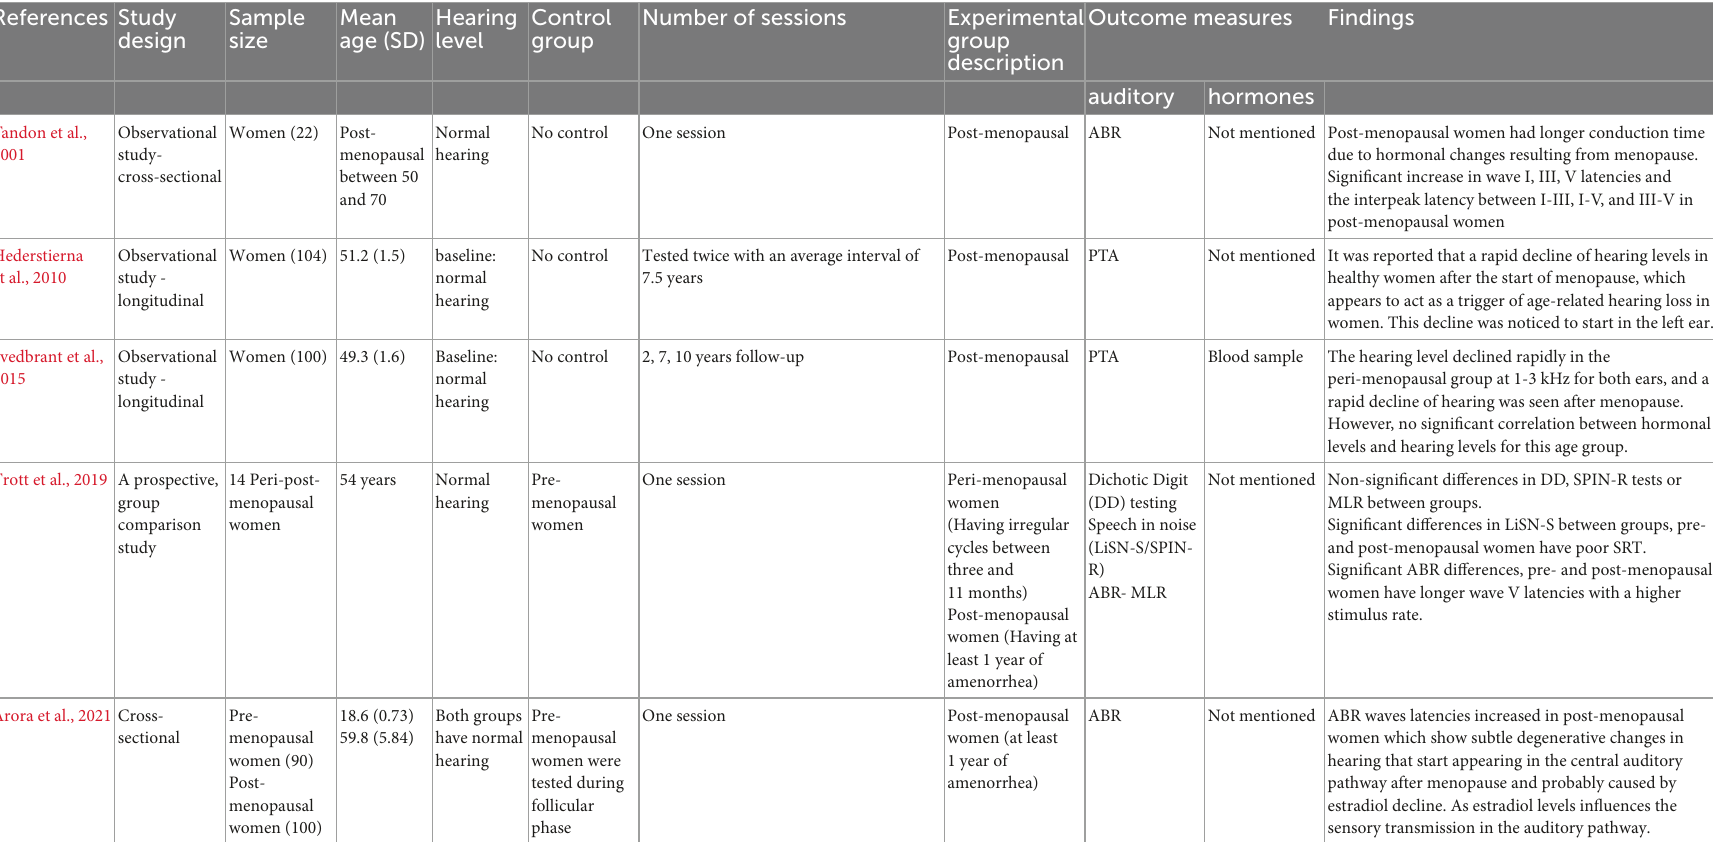
TABLE 3 Summary of the characteristics and results of studies on “the effect of menopause on hearing